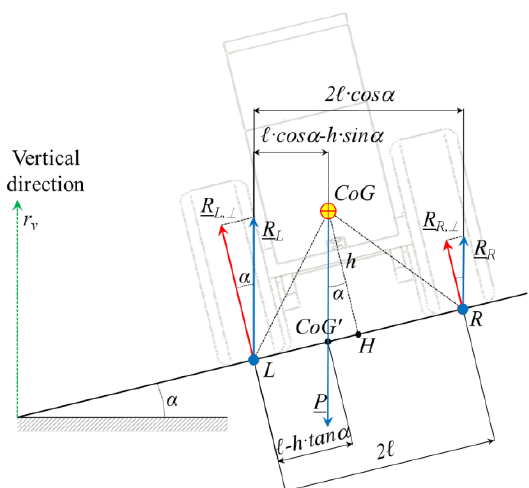
Figure 4. Forces acting on a tractor that is placed motionless on an inclined slope, with the longitudinal axis perpendicular to the maximum slope direction (view from the rear of the tractor).